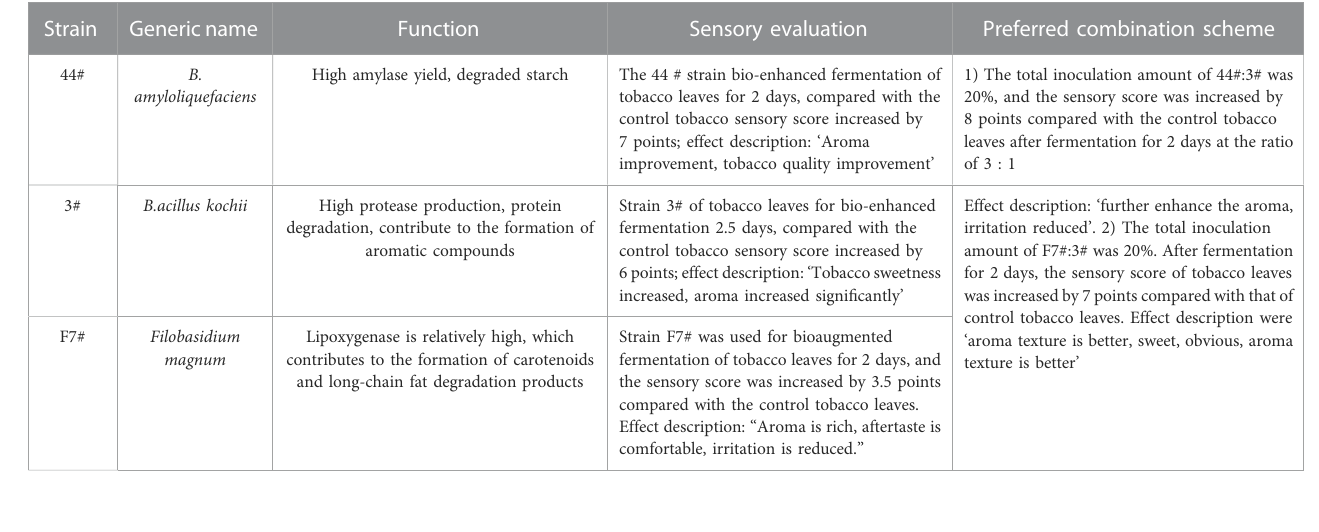
TABLE 7 Function and combination of each strain.